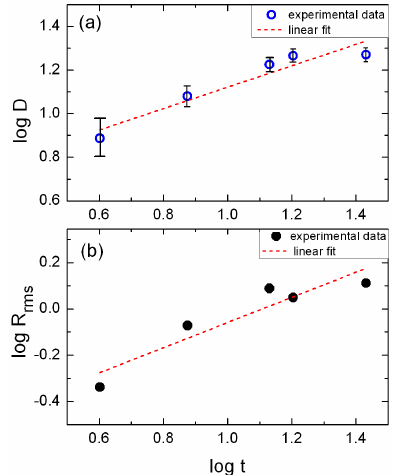
Figure 2. ( a ) Grain diameter D as a function of film thickness t in a log-log plot. The slope of the linear fit has a value consistent with normal grain growth mode. The error bar increases with decreasing film thickness due to the finite tip radius of 7 nm. ( b ) root-mean-square roughness values as a function of film thickness for the same five NiO samples the thickness of which is in the range of 4–27 nm.